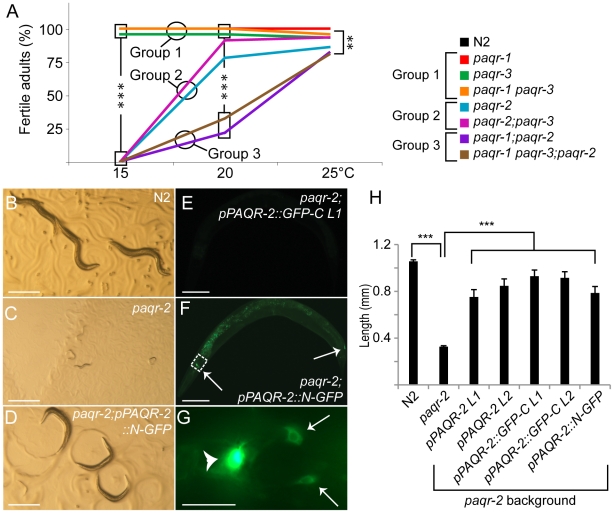

paqr-2 is essential for growth at 15°C.(A) The fraction of individual L1 larvae that grew into fertile adults is shown for different cultivation temperatures. The grouped genotypes are the same as for Fig. 1. (B) and (C) Show wild type or paqr-2 mutant worms grown for 120 hours at 15°C, while (D) shows the growth rescue of paqr-2 worms carrying the pPAQR-2::N-GFP as a transgene. The pPAQR-2::GFP-C transgenics show no visible green fluorescence (E) while the pPAQR-2::N-GFP transgenics show expression of GFP on the plasma membranes of head and tail neurons as indicated by arrows in (F), with (G) being en enlarged view of the area boxed in (F) where the arrowhead indicates a bright neuron that is slightly out of focus. (H) Shows the average length of wild type worms, paqr-2 mutant worms, and paqr-2 mutants transgenic lines carrying the pPAQR-2 transgene (2 lines, L1 and L2), the pPAQR-2::GFP-C transgene (2 lines, L1 and L2) and the pPAQR-2::N-GFP transgene (1 line). *p<0.05, ** p<0.01 and *** p<0.001 using the z-test in (A) and the unpaired Student's t-test in (H). Note that in (A) paqr-2 is also significantly different from controls at 20°C and 25°C with p<0.01 and p<0.05, respectively. Scales indicate 500 µm (B–D), 100 µm (E–F) and 20 µm (G); error bars show the sem.